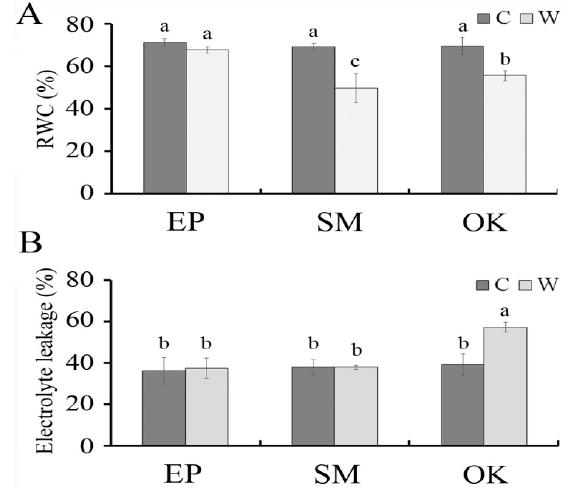
Figure 2. Effects of waterlogging on ( A ) relative water content (RWC, %) and ( B ) electrolyte leakage (EL, %) in EP, SM, and OK plants. Plants were grown under optimally irrigated (control, C, black bars) or waterlogging (W, white bars) conditions for 13 days. Means followed by different letters are significantly different at p ≤ 0.05 by least significant difference (LSD). Vertical bars indicate the standard error ( n = 4).